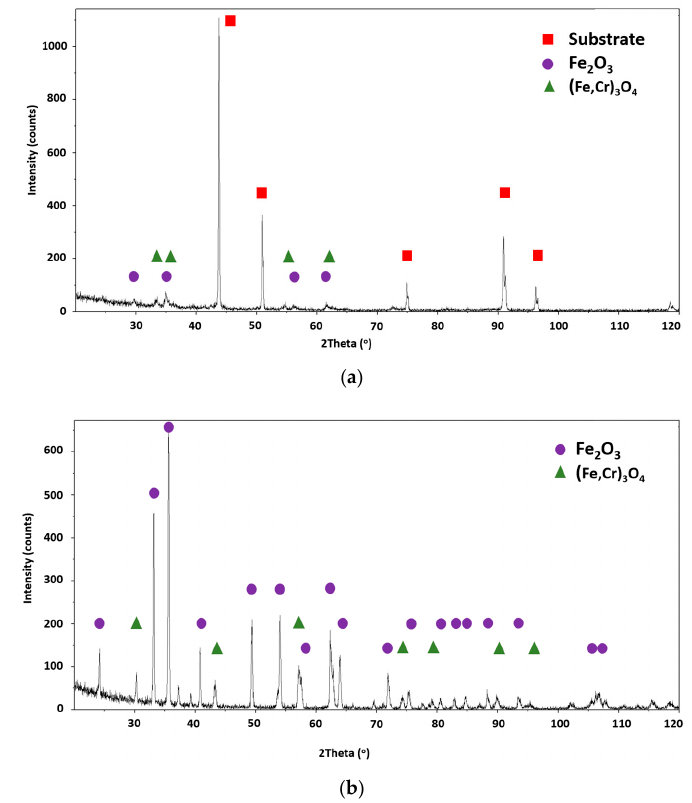
Figure 7. Light microscope cross section of HT347HFG specimens exposed to steam at 700 °C as a function of time and pressure.